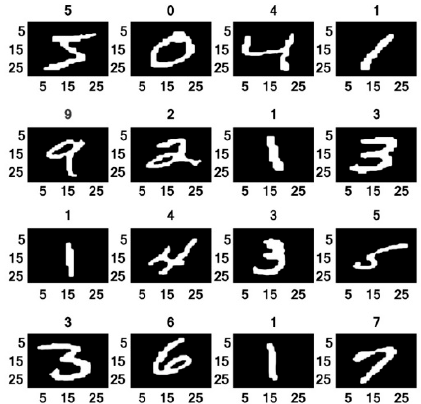
Figure 7. Sample MNIST handwritten digit images.